Question: Condense the content of this figure into a single sentence.
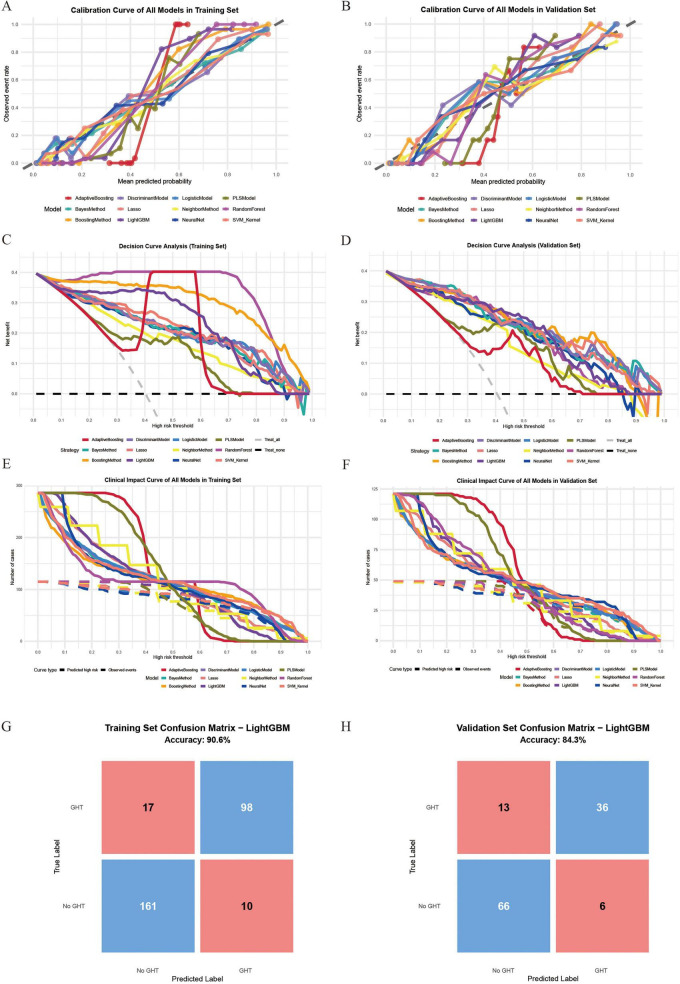
Answer: Calibration, clinical utility, and confusion matrices of the LightGBM model. (A) Calibration curves in the training set. (B) Calibration curves in the validation set. (C) Decision curve analysis in the training set. (D) Decision curve analysis in the validation set. (E) Clinical impact curves in the training set. (F) Clinical impact curves in the validation set. (G) Confusion matrix of the LightGBM model in the training set. (H) Confusion matrix of the LightGBM model in the validation set.